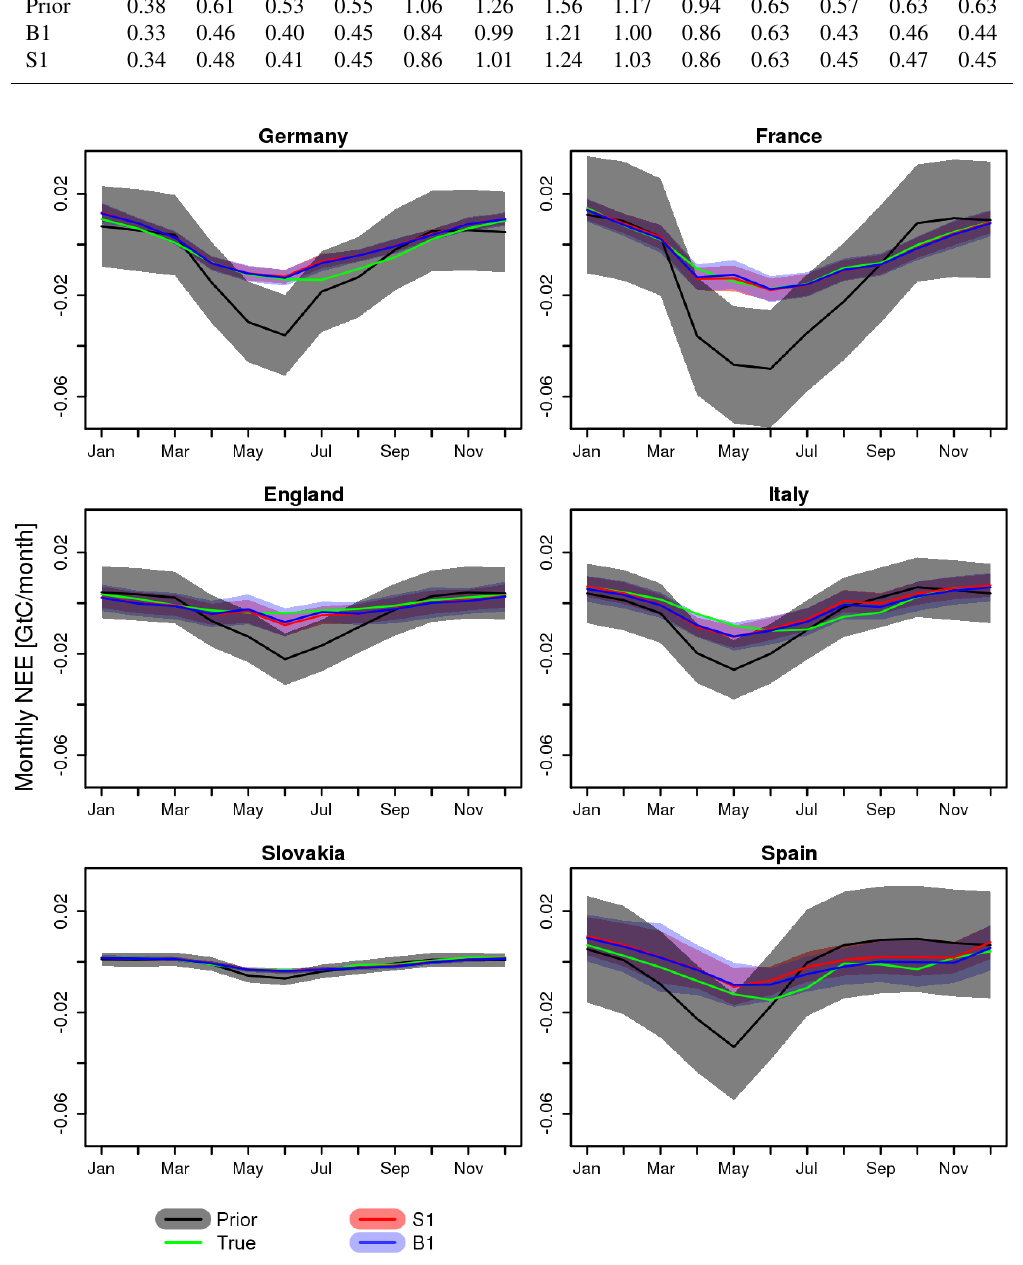
Figure 8. Temporal evolution of monthly NEE for selected European countries for the synthetic data